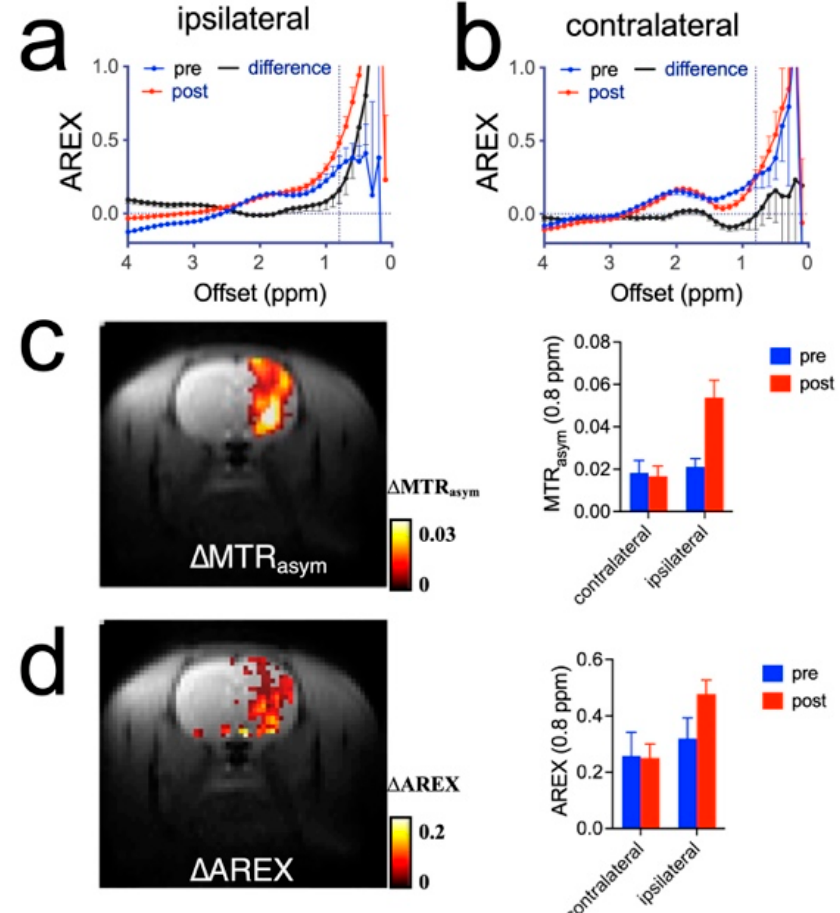
Figure 8. AREX analysis of rats infused with high dose (3 mL 25%) mannitol solution. ( a ) AREX plots of pre- and post-mannitol infusion in the ipsilateral hemisphere in a representative rat. ( b ) AREX plots of pre- and post-mannitol infusion in the contralateral hemisphere of the same rat. ( c ) Overlay image of T 2w image and ∆ MTR asym (0.8 ppm) parametric map (left) and the corresponding mean MTR asym (0.8 ppm) in each hemisphere (right). ( d ) Overlay image of T 2w image and ∆ AREX (0.8 ppm) parametric map (left) and the corresponding mean MTR asym (0.8 ppm) in each hemisphere (right). The comparison of the mean ∆ AREX values between the low and high dose groups voxels in the high dose group were substantially inclined, indicating mannitol